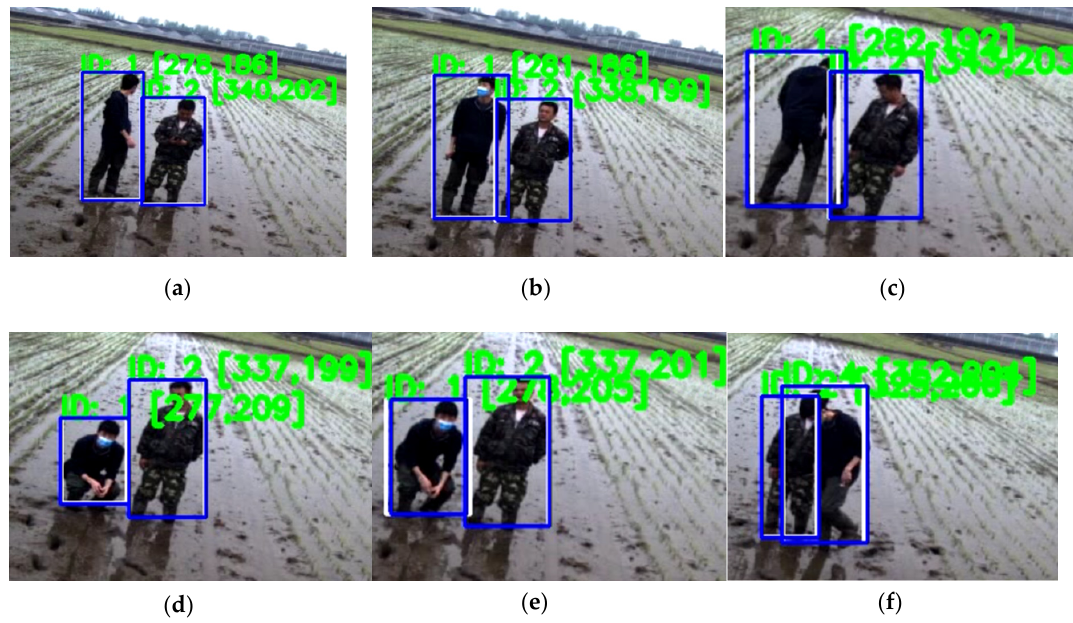
Figure 9. Performance of proposed method. The blue boxes are bounding boxes, the white boxes are tracking boxes. IDs of tracked farmers and center point position of each farmer are figured out by the green color.